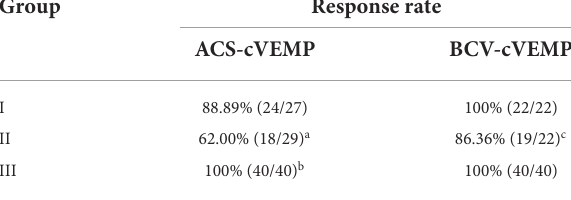
TABLE 2 The response rate of ACS-cVEMP and BCV-cVEMP in three groups.